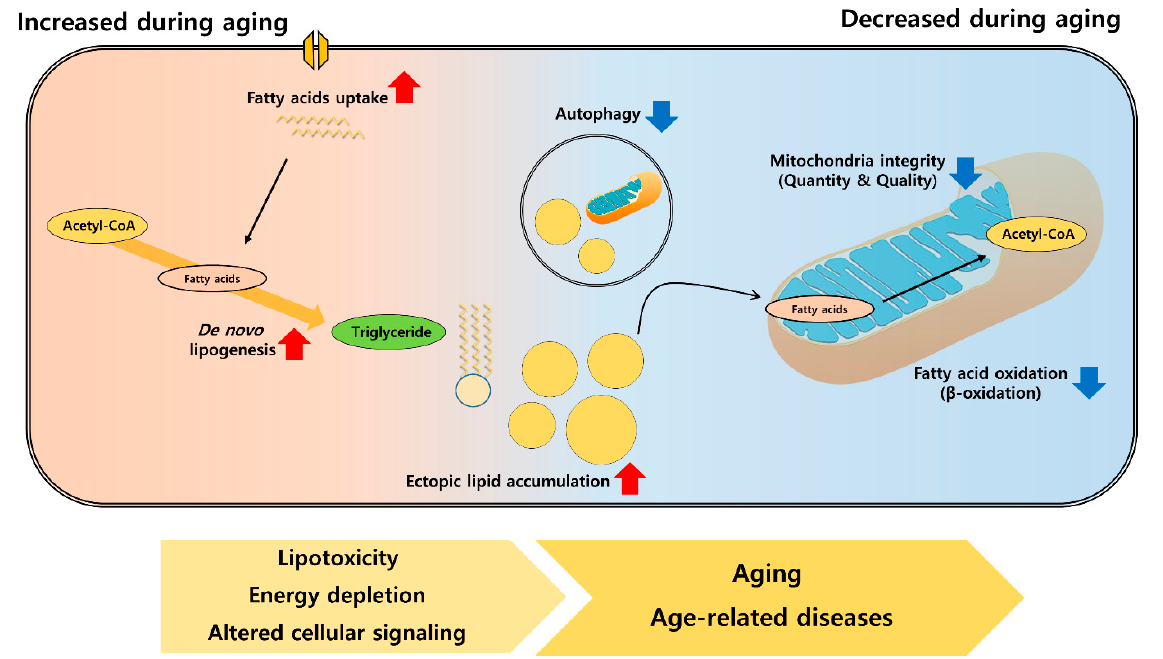
Figure 1. Age-related changes in lipid metabolism and their effects on aging and age-related diseases. Ectopic lipid accumulation occurring during aging is mainly induced by increased fatty acids uptake, de novo lipogenesis, with decreased fatty acid oxidation process. Mitochondrial integrity and autophagic induction is also diminished during aging leading to decreased lipid catabolism. These changes further bring lipotoxicity in the cell, deplete energy in the tissue, and alter cellular signaling causing accelerated aging and early onset of age-related diseases.